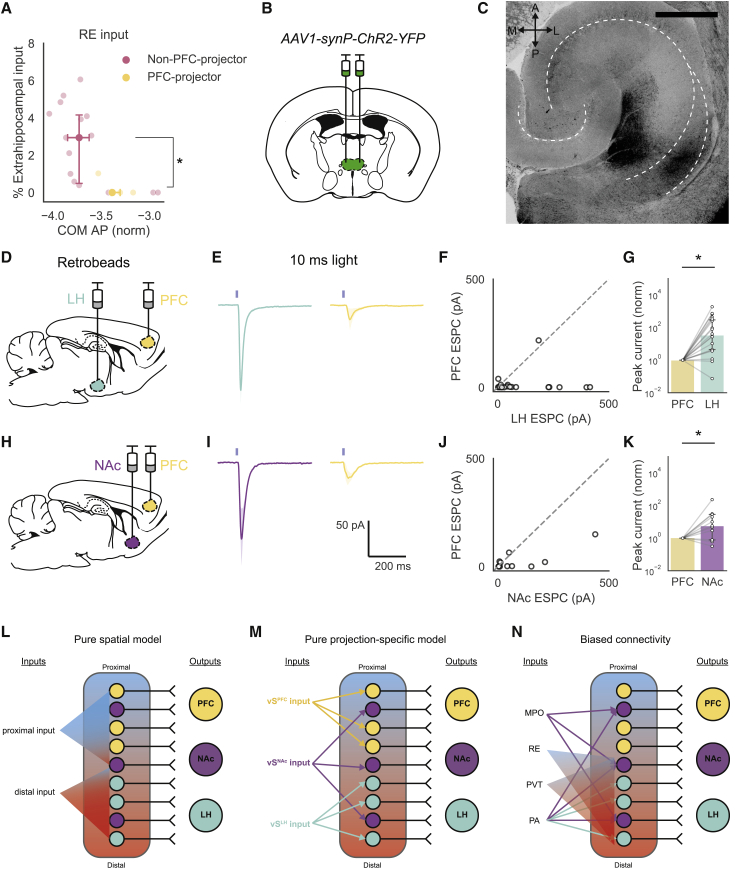
Nucleus Reuniens Inputs to vS Projection Neurons Are Functionally Biased(A) Extrahippocampal fractions of RE inputs as a function of COM and projection population. Non-PFC projectors (i.e., pooled vSNAc and vSLH) have overall higher RE inputs than vSPFC (n = 15 non-PFC projectors, n = 5 PFC-projectors; Mann-Whitney U test, U = 12.0, p = 0.013). Data are summarized as median and interquartile range.(B) AAV expressing ChR2 under the synapsin promoter was injected bilaterally into RE.(C) Stitched confocal image of a horizontal section of hippocampus. RE axons expressing ChR2 target distal regions of vS. Scale bar: 500 μm.(D and H) In the same surgery after ChR2 injection into RE, red and green retrobeads were injected into either LH and PFC (D) or NAc and PFC (H).(E and I) Light-evoked excitatory postsynaptic currents in pairs of (E) vSLH and vSPFC or (I) vSNAc and vSPFC. All data represent responses to 10 ms of blue light. Solid line: mean response; shaded region: 95% confidence interval.(F and J) Scatterplots of light-evoked photocurrents from vSLH and vSPFC cell pairs (F) and vSNAc and vSPFC cell pairs (J).(G and K) Normalized EPSCs from vSLH (G) and vSNAc (K) neurons scaled to the photocurrent elicited in neighboring vSPFC neurons; the relative amplitudes of light-evoked photocurrents are higher in vSLH (Wilcoxon signed-rank test, n = 18 pairs from 3 animals, V = 4.0, p = 3.86 × 10−4) and vSNAc (Wilcoxon signed-rank test, n = 11 pairs from 3 animals, V = 6.0, p = 0.016). Data are summarized as median ± 95% confidence intervals.(L–N) Models of vS input connectivity based purely on (L) spatial location or (M) projection identity. (N) Our dataset supports a combined model from (L) and (M), where inputs can be either projection or COM dependent.See also Figure S4.